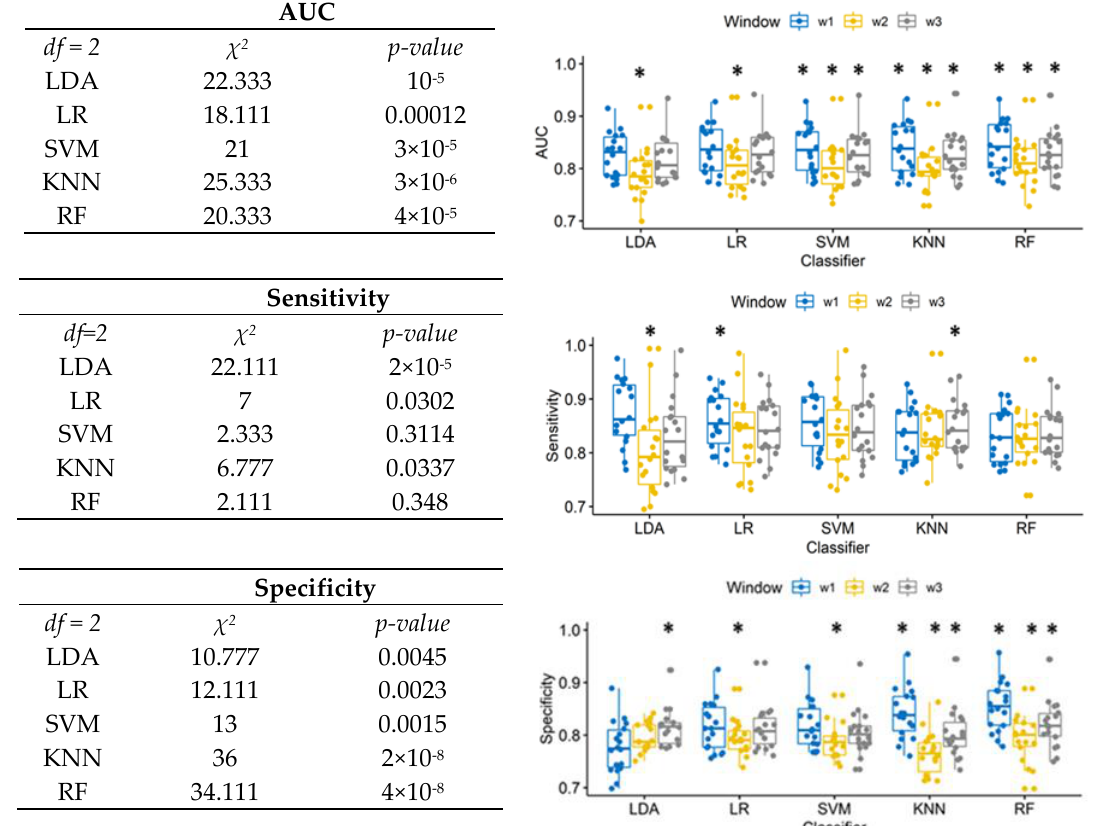
Figure 1. Left: Friedman test results to compare window e ff ects for each classifier in terms of AUC, sensitivity, and specificity. Right: box plot of the AUC, sensitivity, and specificity for different segmentations (win1 = 10 ms, win2 = 50 ms, win3 = 100 ms). The asterisks * showed the post-hoc results. Please define *.